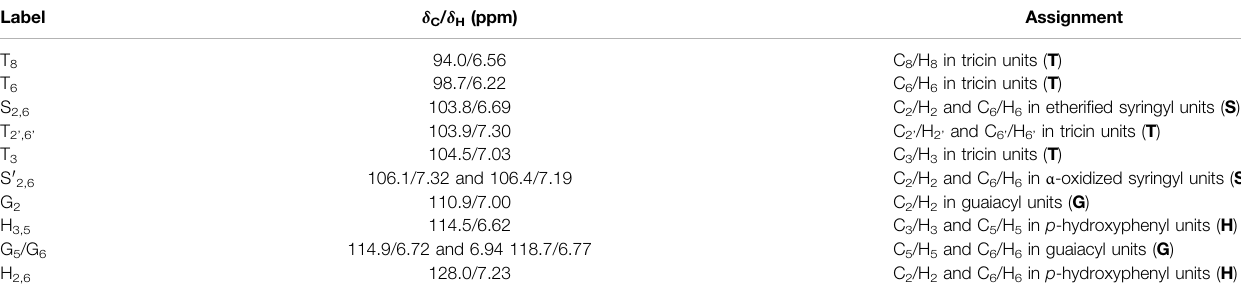
TABLE 2 | Assignments of 1 H/ 13 C correlation signals in the 2D HSQC spectra of the lignin in DMSO- d 6 . Label